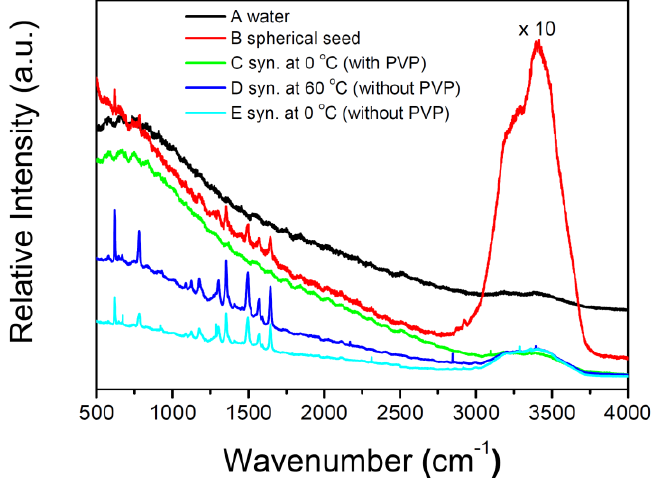
Figure 11. Fluorescence or surface-enhanced Raman spectroscopy (SERS) spectra of 5 × 10 −9 M R6G probe molecule excited with a 532-nm laser in several kinds of solutions: ( A ) in water; ( B ) spherical silver NP seed colloid; ( C ) decahedral silver NP colloid (synthesized at 0 °C in the presence of Polyvinylpyrrolidone (PVP)); ( D ) silver nanoplate colloid (synthesized at 60 °C); ( E ) decahedral silver NP colloid (synthesized at 0 °C without the addition of PVP and 16-mercaptohexadecanoic acid (16-MHDA)). 0.05 M KBr were added to the above solutions for 30 min prior to spectroscopic